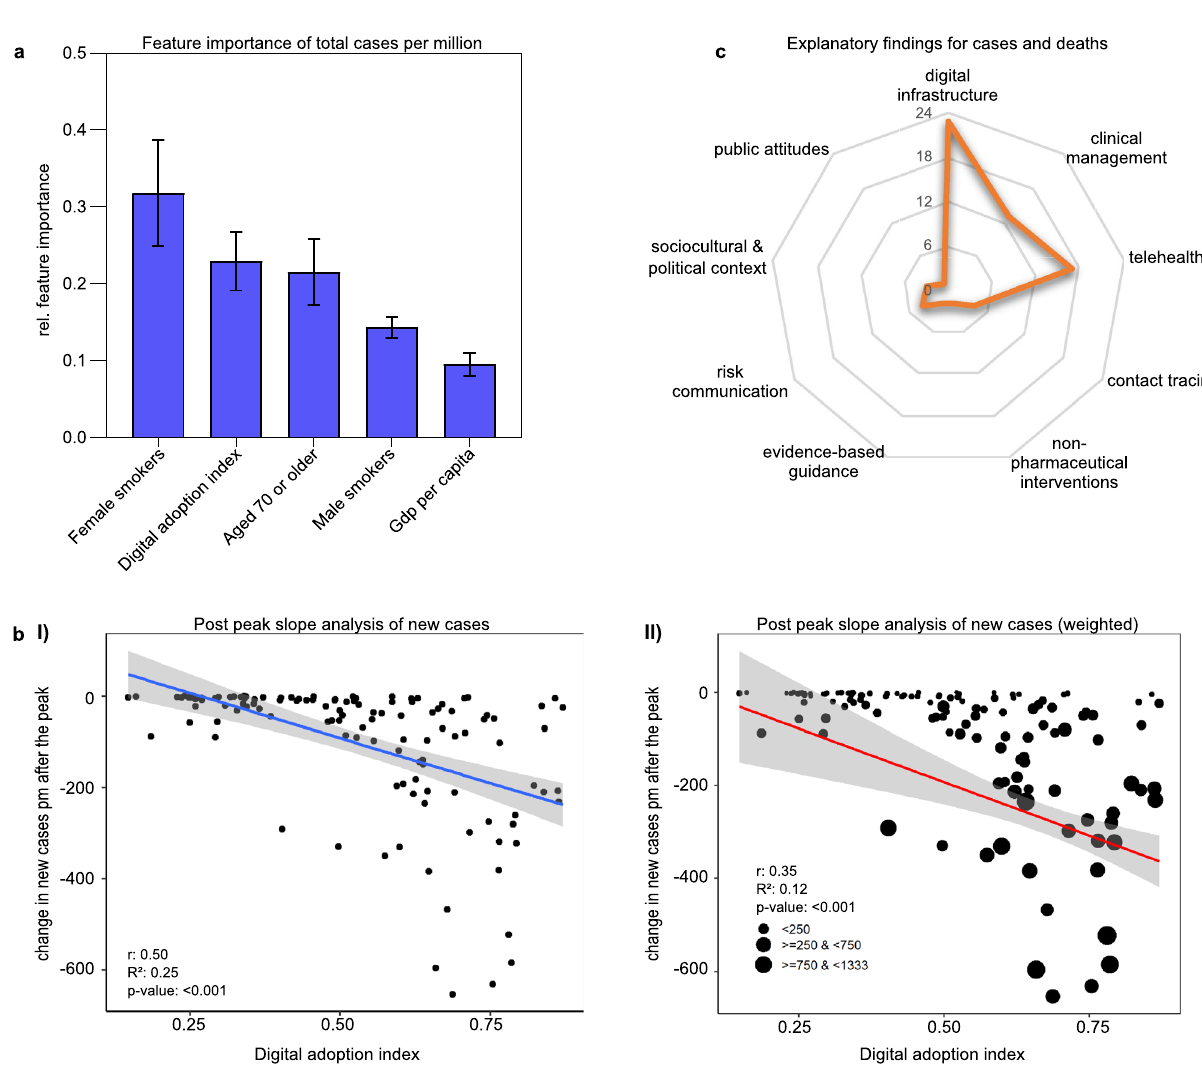
Figure 2. The impact of digital adoption on the development of COVID-19 cases. ( a ) The gradient tree boosting results show the five most important characteristics for peak total COVID-19 cases in 2020 out of 15 features. Relative feature importance was normalized, and the sum was set to 1.0. Data are expressed as mean ± standard error of the mean. ( b ) Change in new cases pm after the peak in 2020–2021. (I) The result of the simple linear regression illustrates the effect of the DAI on the reduction in new COVID-19 cases (7-day- smoothed) pm in the post-peak period. Countries with higher DAI were more efficient in significantly reducing the number of new cases. (II) The second regression is weighted by the delta of minimum and maximum new cases to show the impact of more successful countries in lowering the new case numbers. The blue (I) and red (II) lines indicate the linear fits of regression analyses. The areas of the 95% confidence intervals are shaded gray. DAI is expressed as an arbitrary unit. ( c ) The radar chart displays the keywords addressed in the "health care system" theme of the scoping review. The scale for the radial axis diagrams shows how frequently the keywords occurred in the included studies. Papers may contain different numbers of